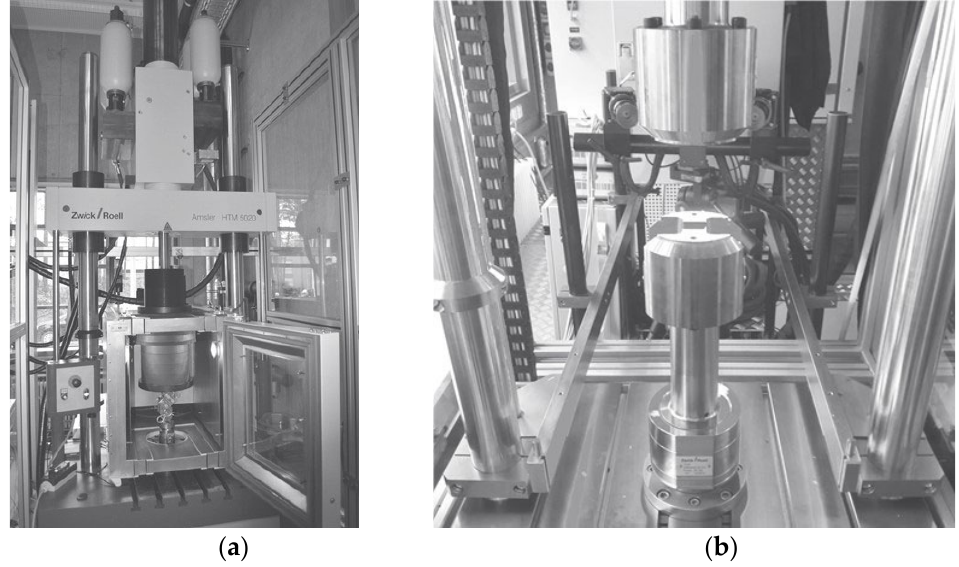
Figure 5. Testing equipment: ( a ) High ‐ speed tensile testing with a Zwick HTM 5020; ( b ) Cyclic testing with a servo ‐ hydraulic pulser Zwick HCT 25.